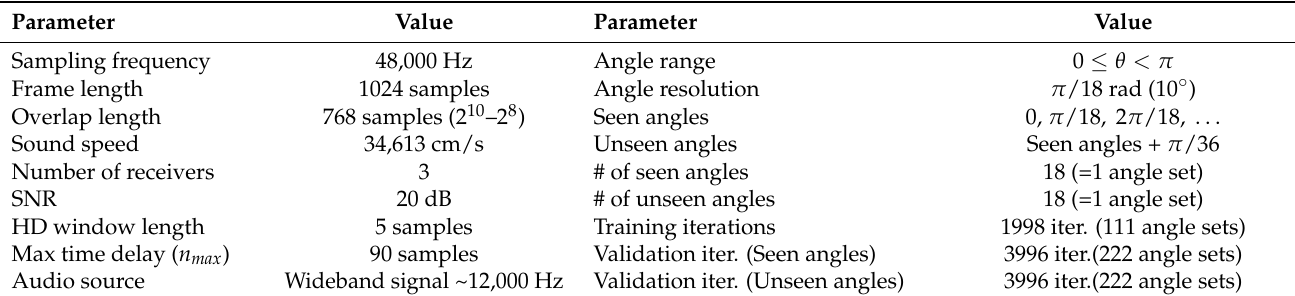
Table 2. Simulation parameters and values.